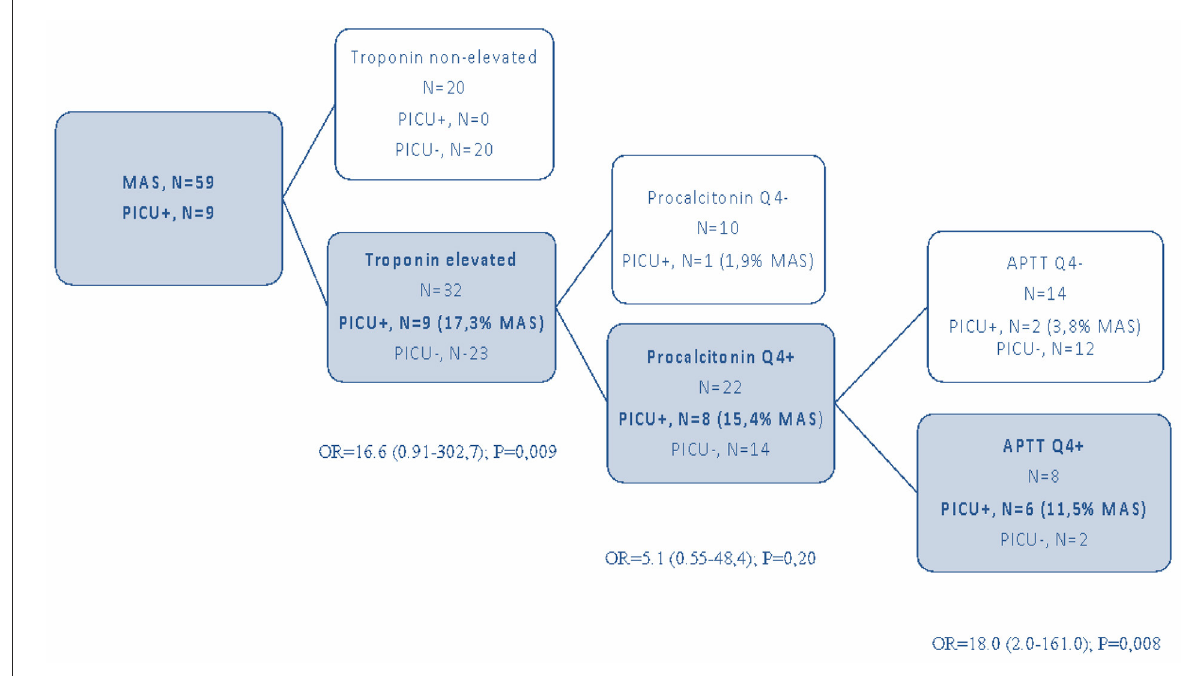
FIGURE2 Predictive factors for PICU hospitalization in children with MIS-C and MAS.